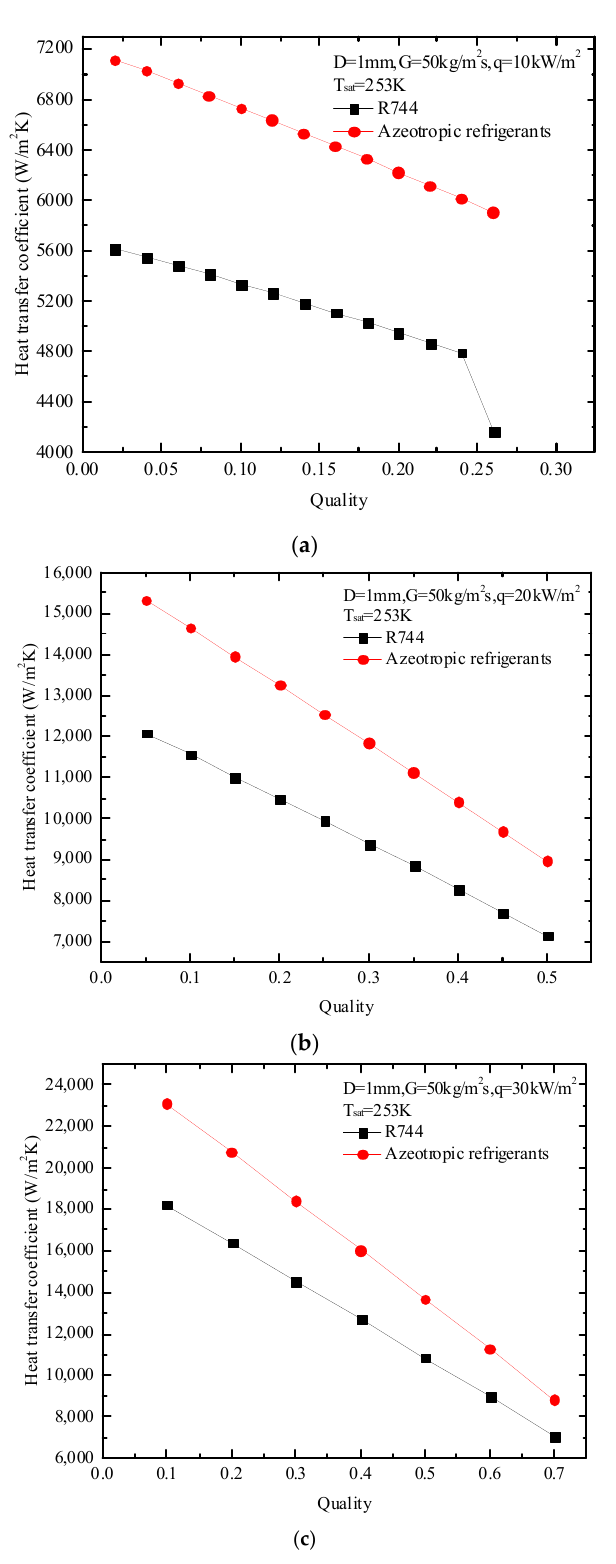
Figure 17. Comparison of heat transfer coefficients between azeotropic refrigerant and R744 at different heat fluxes: ( a ) q = 10 kW; ( b ) q = 20 kW; ( c ) q = 30 kW.